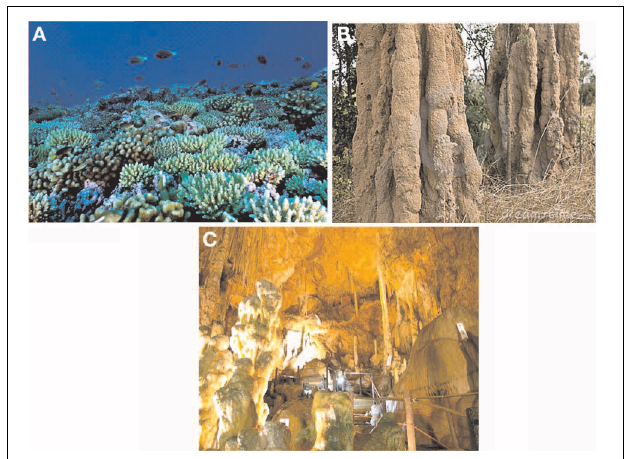
FIGURE 1 | Bio-mineralization of calcium carbonates in natural structures (A) Corals (B) Ant hills (C) Limestone caves ( www